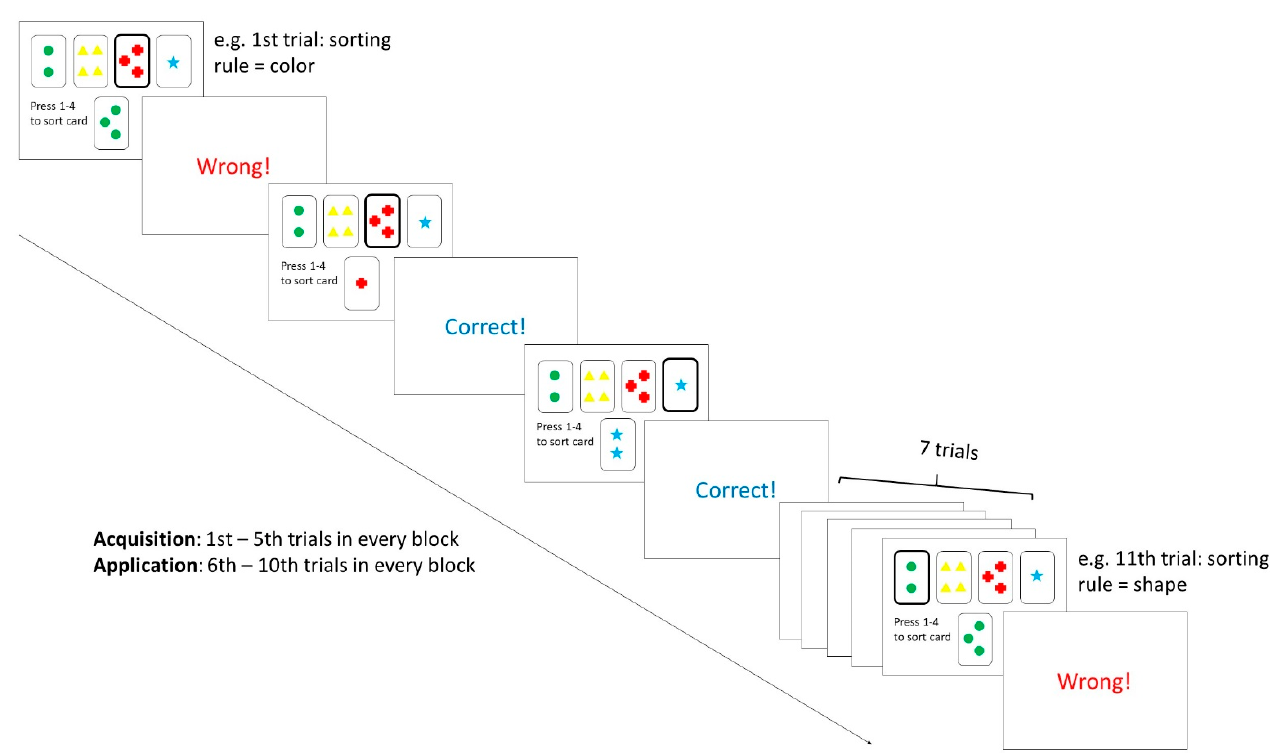
Figure 2. Experimental design. The WCST-64 paradigm consists of six blocks with 10 trials for each block. Participants were asked to sort the stimulus card by a rule (color, shape, number) that was not disclosed to them. The rule changes after every 10 trials and the rule order were counterbalanced among subjects. In every trial, participants were presented with one stimulus card ( below ) and four reference cards (( top row ); remained unchanged throughout the whole paradigm). The order of stimulus cards was random. Feedback indicating choice accuracy was given immediately after each response was made.